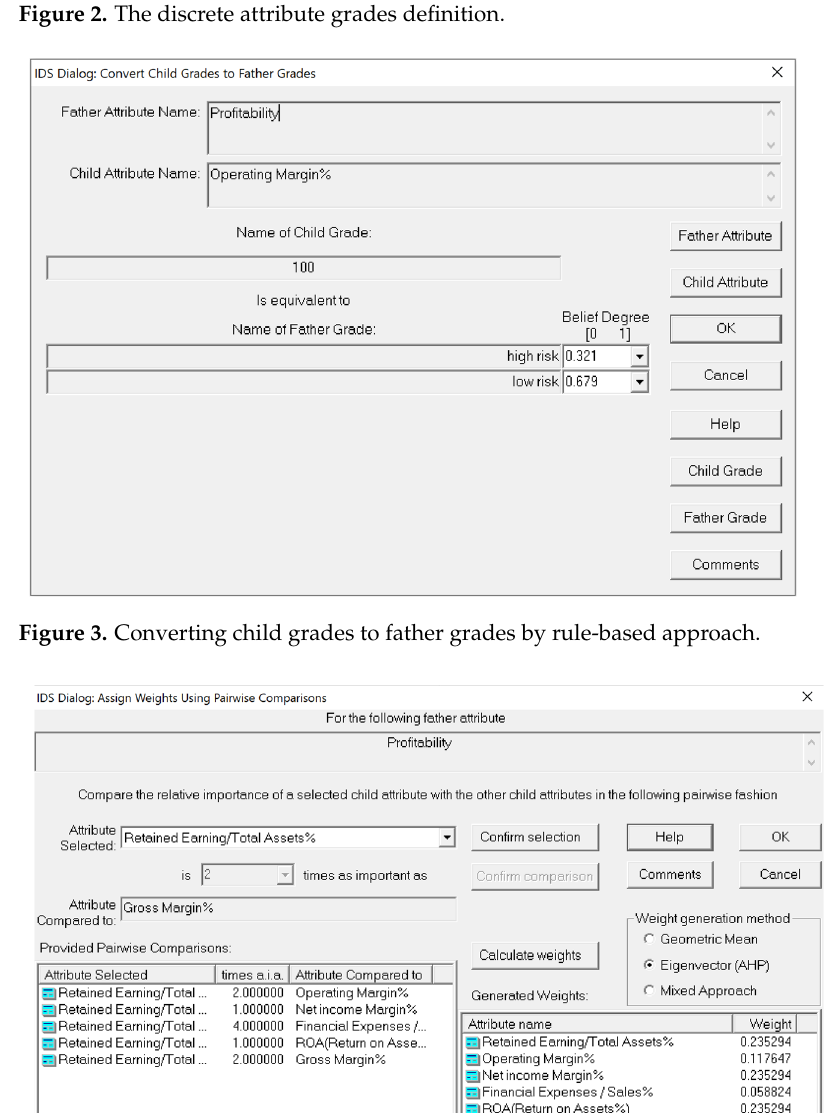
Figure 5. Collecting data for alternatives. 3.2. Result Discussion The utilities of the top-level attribute are assigned as follows, 𝑢(cid:4666)𝐻 (cid:2869) (cid:4667) = 𝑢(cid:4666)ℎ𝑖𝑔ℎ 𝑟𝑖𝑠𝑘(cid:4667) = 0 𝑢(cid:4666)𝐻 (cid:2870) (cid:4667) = 𝑢(cid:4666)𝑙𝑜𝑤 𝑟𝑖𝑠𝑘(cid:4667) = 1 The assessment result is a probability distribution and can also be an average score generated by multiplying the utilities of grades by the product of normalized weight and the degree of belief. Figure 6 shows an example of the assessment result for alternative FAIR, which is an active company. The probability distribution is